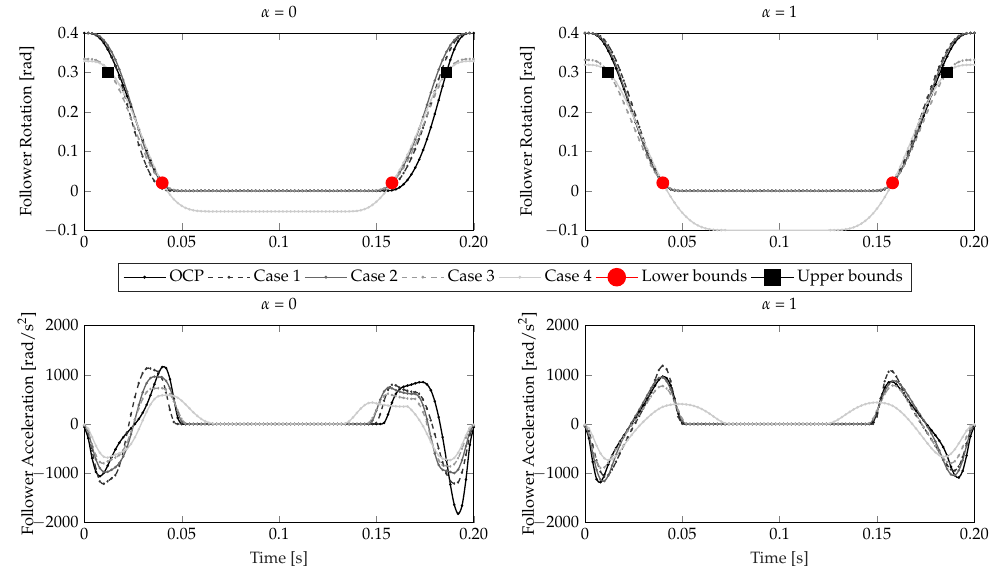
Figure 13. Co-design result: follower rotation and accelerations.